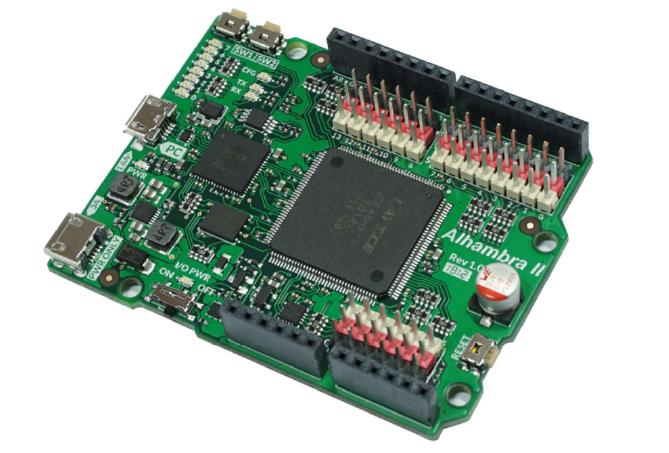
Figure 1. Icezum Alhambra II